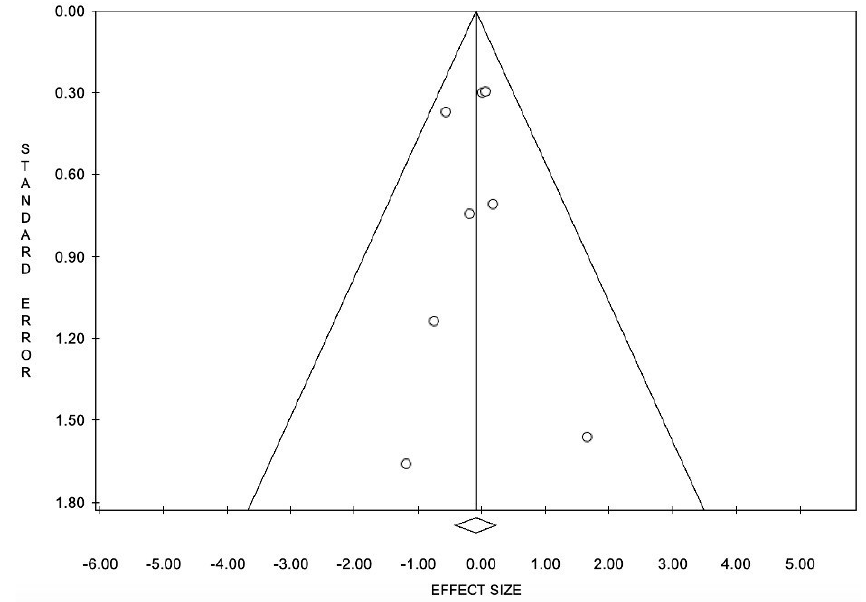
Figure 6. Funnel plot for meta-analysis of incidence of myalgia. Funnel depicts no publication bias for meta-analysis of myalgia incidence in anti-PCSK9 group vs. control group.